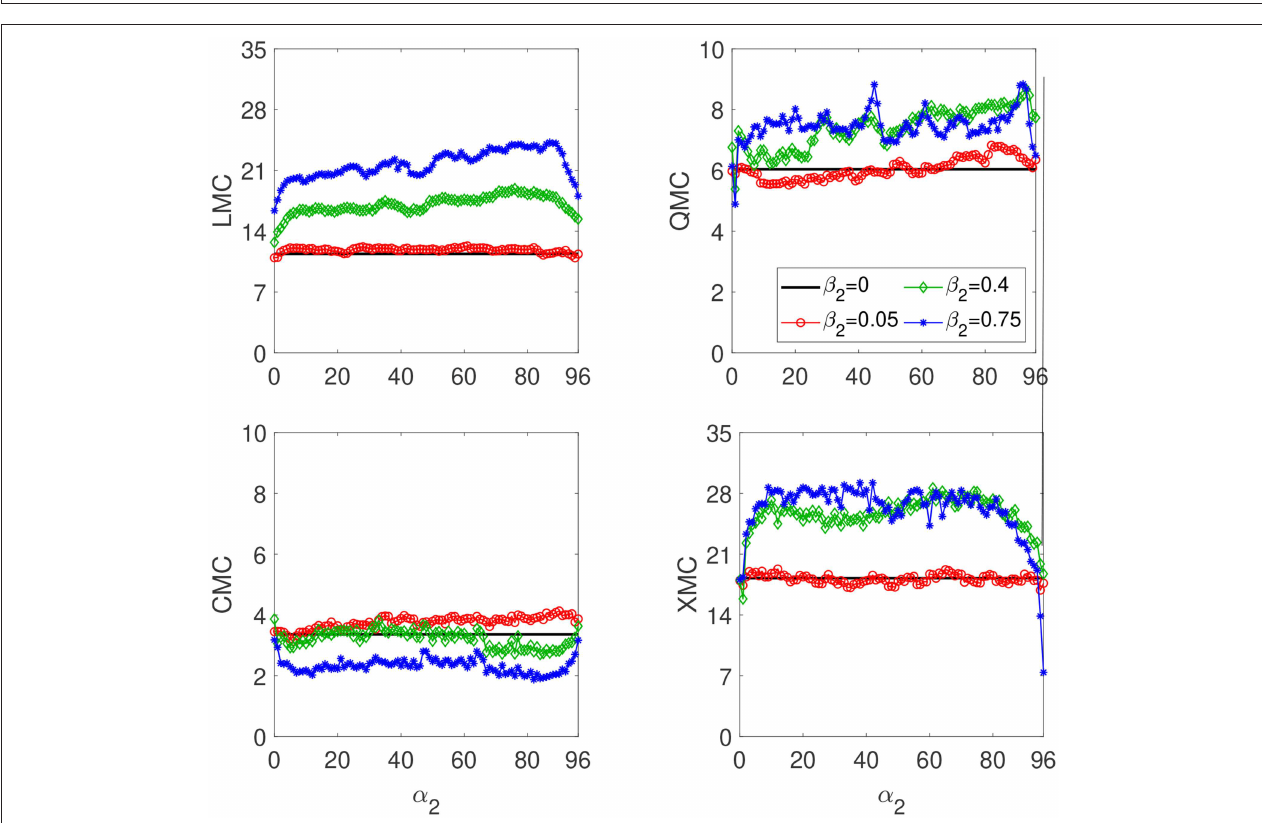
FIGURE 6 | Memory capacities for the two-delay RC as function of α 2 for a fixed α 1 = 1, T = θ/ 0.2 and γ = 0.1. The red circles, green diamonds and blue stars correspond to β 2 equal to 0.05, 0.4, and 0.75, respectively. The solid black line is for β 2 = 0 and corresponds to the one-delay system with α = 1 and β =